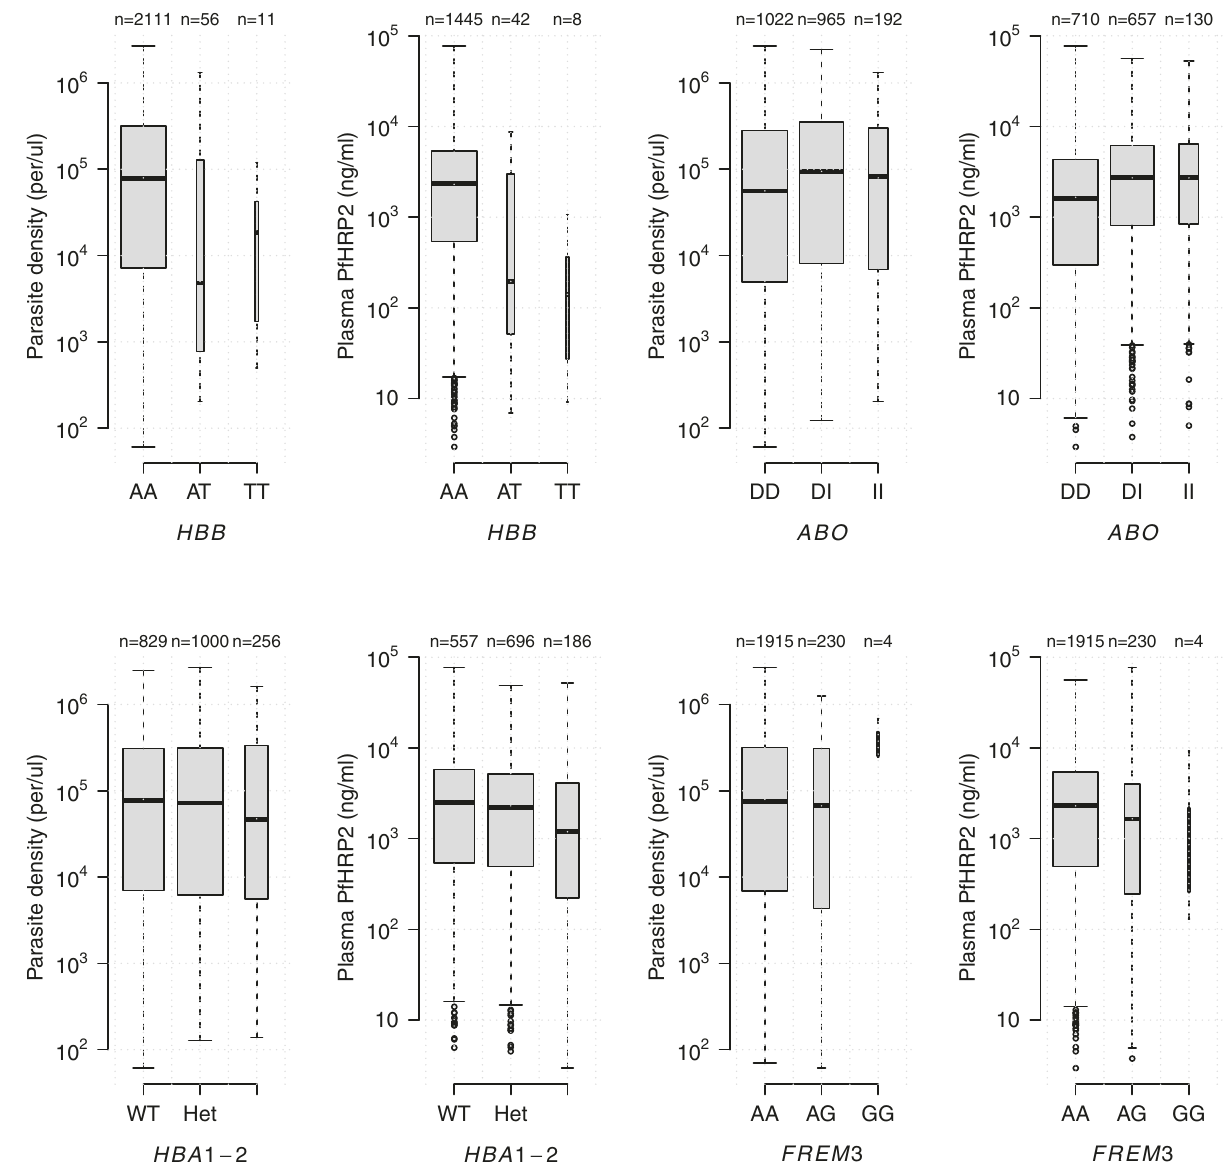
Fig. 2 Distributions of plasma Pf HRP2 and parasite density across HBB (rs344), ABO (rs8176719), HBA1-2 ( α -thalassemia), and FREM3/GYP (rs186873296) genotypes. Boxplots (center: median; bounds of box: interquartile range; whiskers: 1.5 standard deviations; points: outliers) are based on observed data; the width of each boxplot is proportional to the square root of the number of data